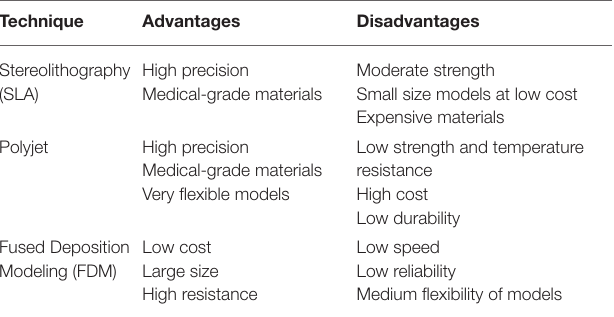
TABLE 1 | Advantages and drawbacks of the most common 3D printing techniques.